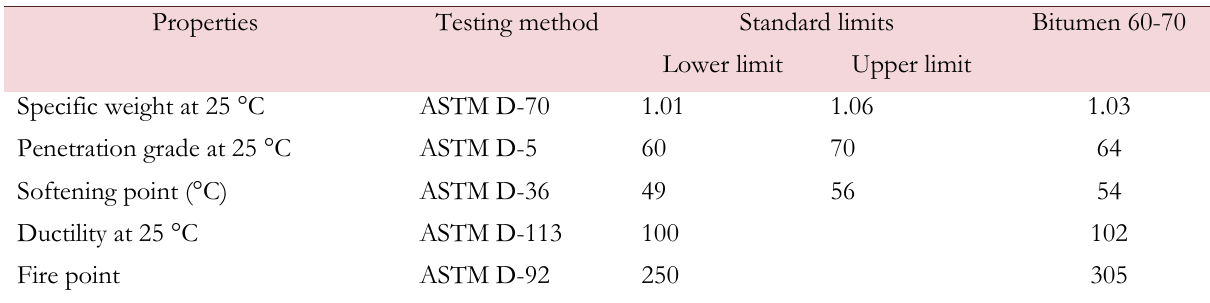
Table 1: Specifications of